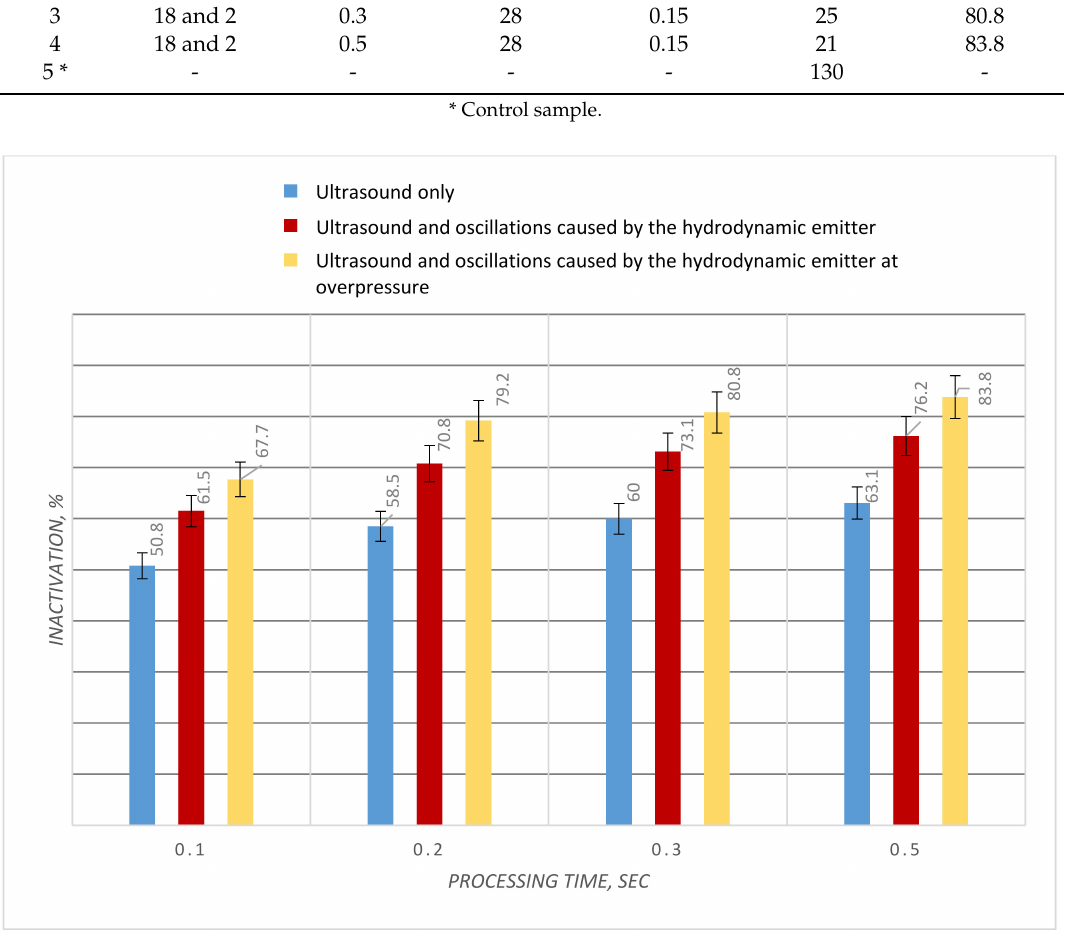
Figure 3. A comparative histogram of microorganism inactivation under various